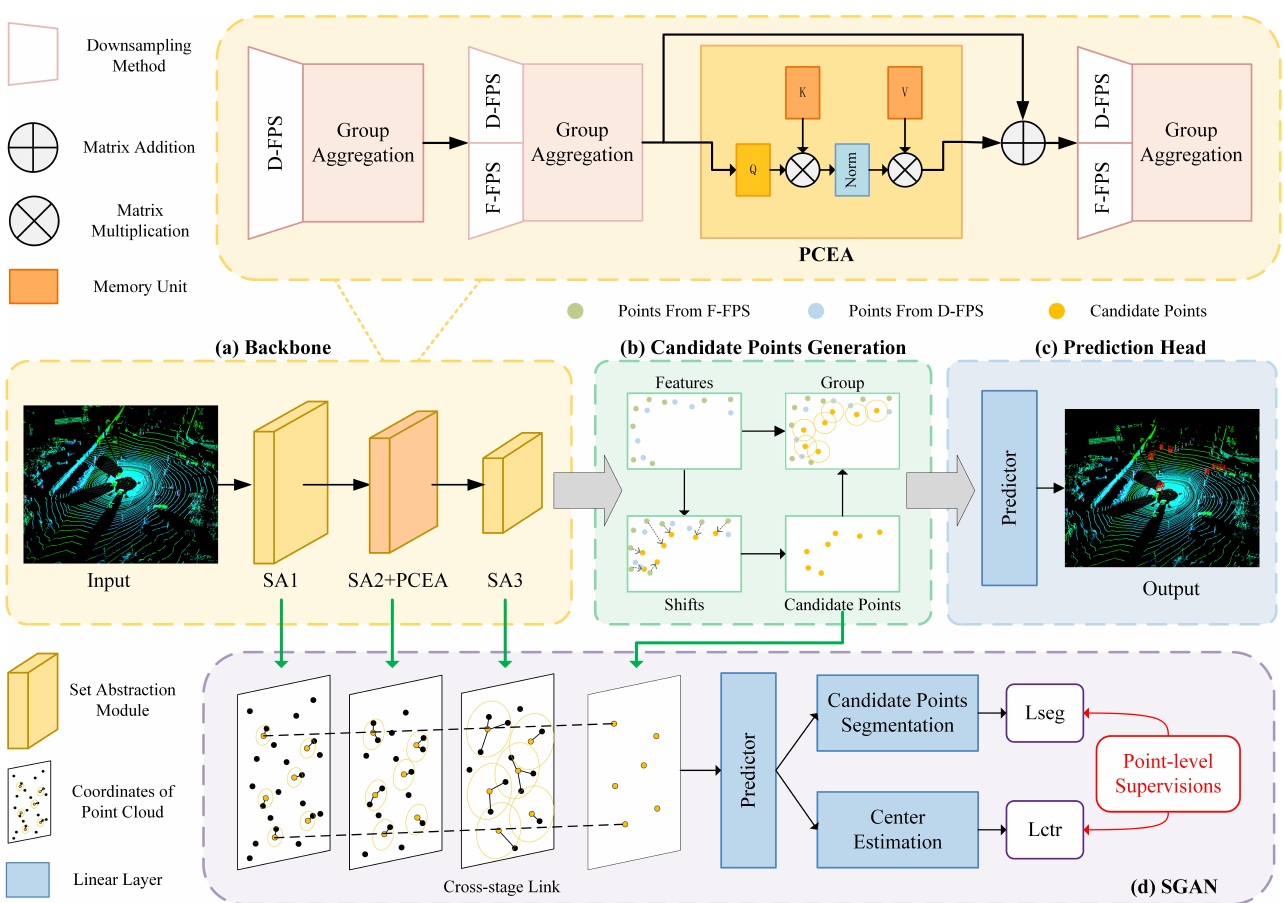
Figure 1. Illustration of SGSSD framework. ( a ) Backbone network. It takes the raw point cloud as input and generates global features through several SA layers, PCEA is added after SA2. D-FPS and F-FPS mean FPS in Euclidean and feature space, respectively. ( b ) Candidate points generation layer. The points after shifts are used for prediction, we call them candidate points. ( c ) Prediction head. ( d ) Auxiliary module SGAN. It is detachable after